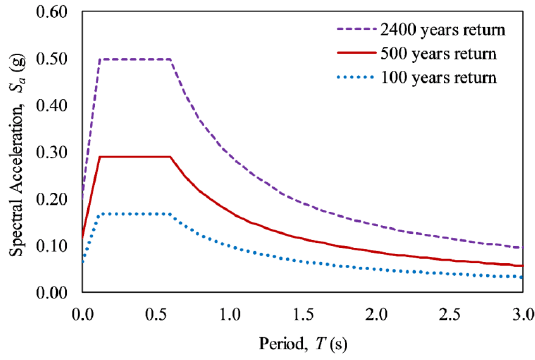
Figure 5. Soil type S D-1 elastic response spectra (5% damping) of KDS for 100, 500, and 2400 years return.